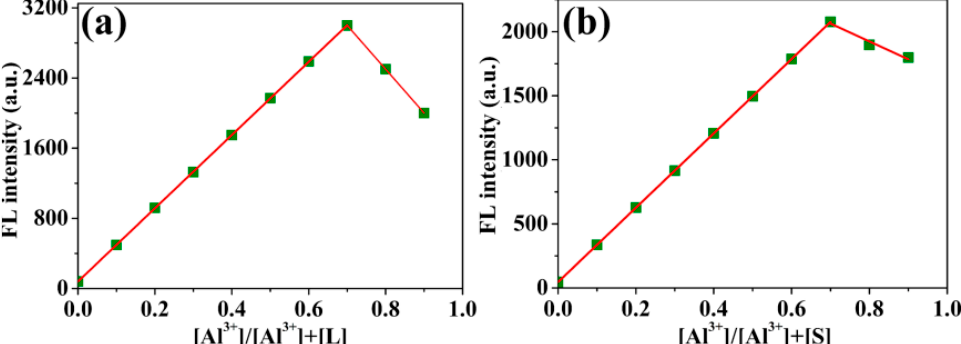
Figure 5. Job’s plot showing the 1:2 complex of L ( a ) and S ( b ) with Al 3+ in DMSO/H 2 O ( v : v = 8:2) solution.